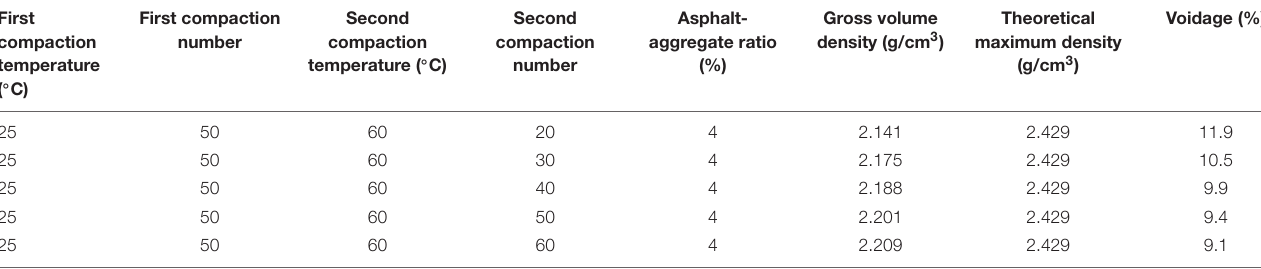
TABLE 7 | Recommended grading standard for cold recycled